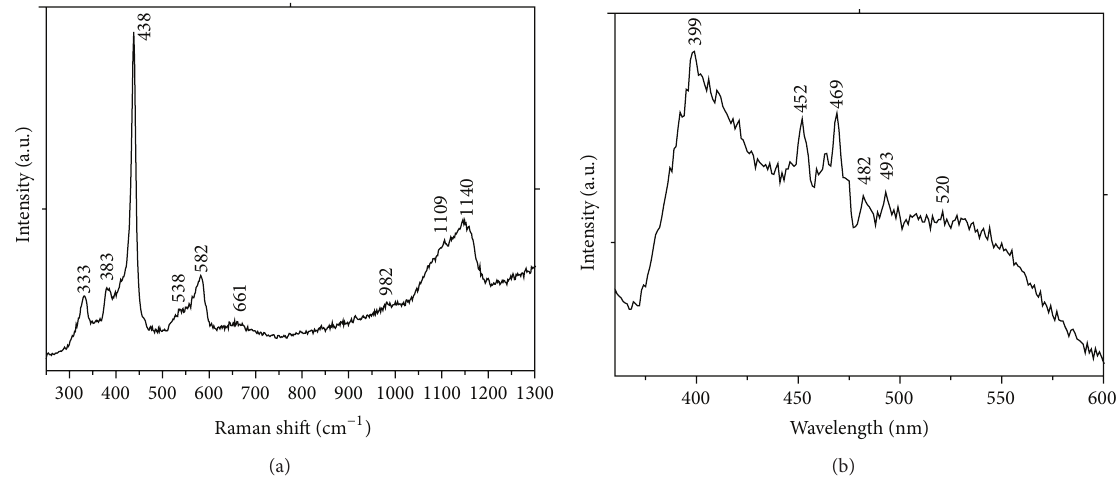
Figure 4: (a) Raman spectrum of the as-prepared ZnO nanorods with excitation wavelength 514.5 nm. (b) Room temperature PL spectrum of the ZnO nanorods with excitation wavelength 325